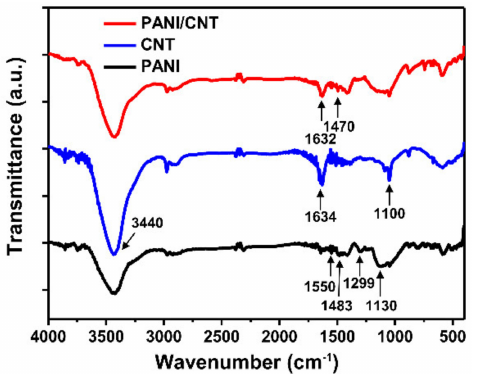
Figure 3. Fourier-transform infrared spectroscopy (FT-IR) spectra of the PANI, CNT, and PANI/CNT